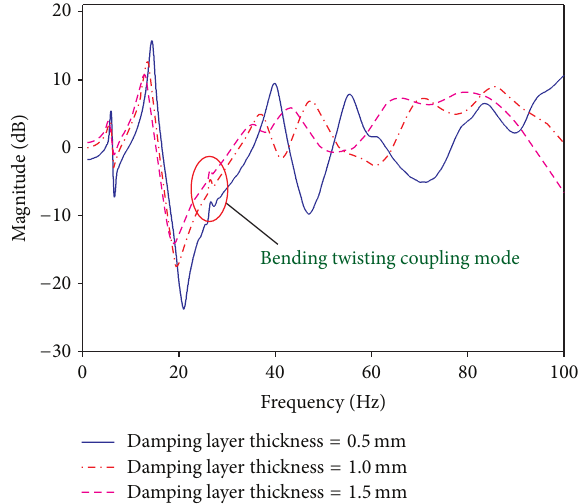
Figure6: Frequencyresponsefunctionsoffiberreinforcedcompos- ite wind blade with variation of thickness of damping layer ( 𝜂 = 1